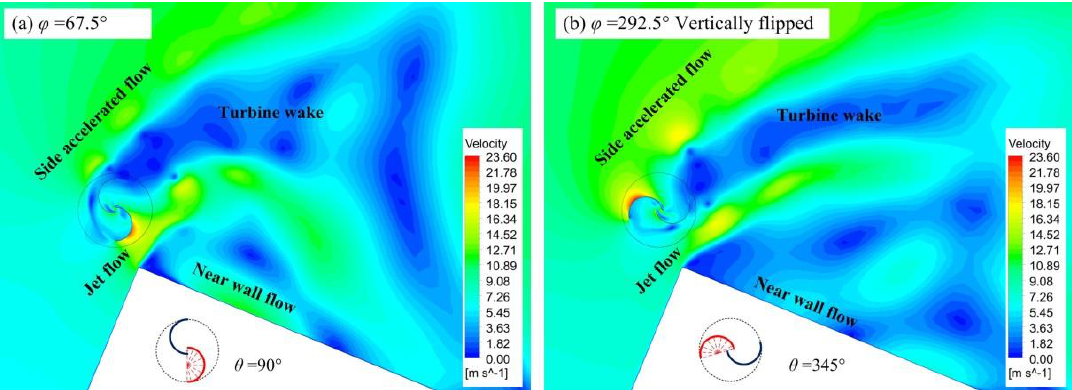
Figure 22. Velocity contours around the turbine at TSR = 1.2 and at ( a ) θ = 90°, φ = 67.5° and ( b ) θ = 345°, φ = 292.5°.